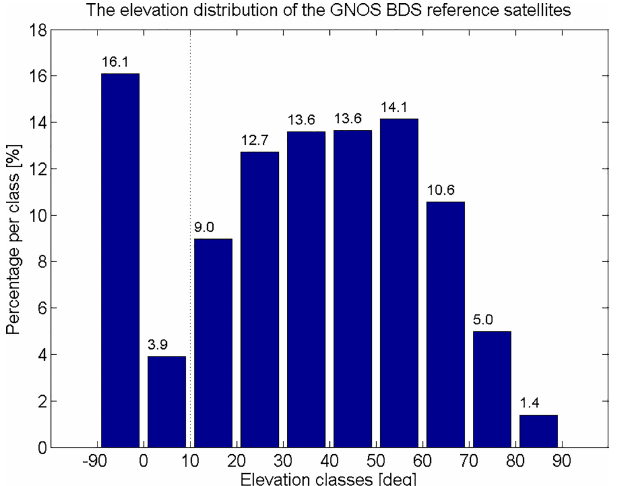
Figure 4. Histogram of the maximum elevation angle of the BDS reference satellites, with the statistics based on the 13564 BDS RO events that occurred over October–December